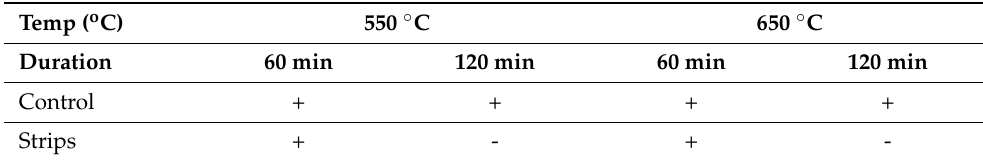
Strips - + indicates growth, and - indicates no growth. Table 10. Results of exposure of sporulating bacteria to methyl soyate aerosols. Temp ( ◦ C)